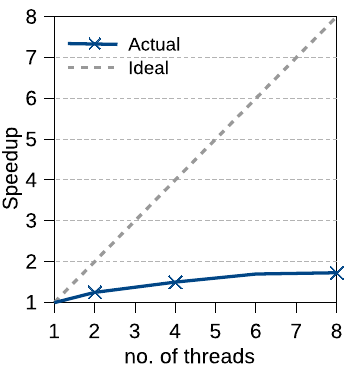
Figure 13. The speedup of generating 30000